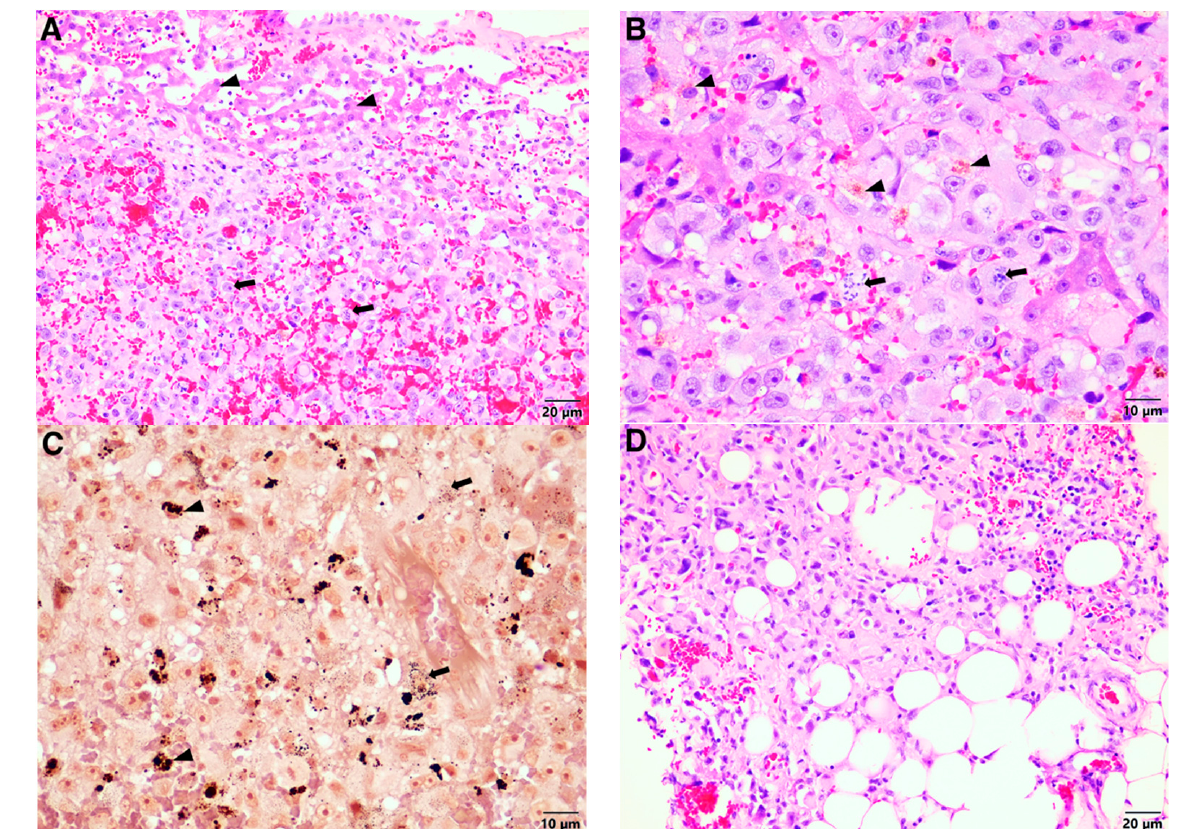
Figure 2. Malignant melanoma, lion: histopathology of the liver and omentum. ( A ) Poorly defined proliferation of neoplastic cells ( arrows ), compressing a small area of non-neoplastic hepatocytes ( arrowheads ). ( B ) Pleomorphic round to oval to polygonal neoplastic cells with small to large amounts of pale eosinophilic finely vacuolar cytoplasm. Mitoses were present in all high power fields ( arrows ) and brown pigment-laden cells were common ( arrowheads ). ( C ) The pigment within the neoplastic cells stained typical for melanin using Fontana-Masson special stain. The melanin pigment varied from finely granular ( arrows ) to coarsely granular ( arrowheads ). ( D ) Proliferating neoplastic cells within the adipose tissue of the omentum.